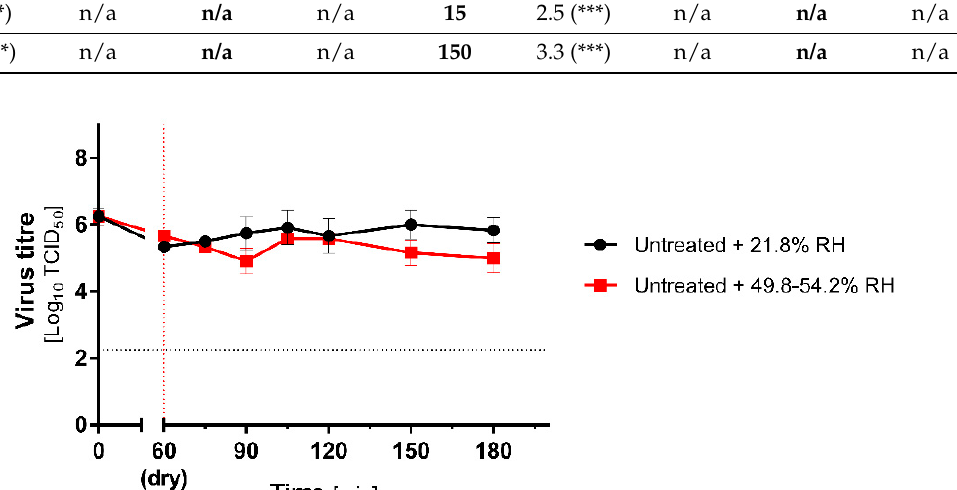
Figure 2. MHV stability on carriers. Stability of the MHV virus during 60 min drying on non-porous, stainless-steel surface, followed by 120 min incubation at 21.8% (low RH; black lines) or 49.8–54.2% (high RH; red lines) RH. Virus titre is calculated as mean ( ± SD, n = 3). The vertical dotted line represents the end of drying, and the horizontal dotted line represents 4 logs virucidal efficiency with respect to the initial titre.